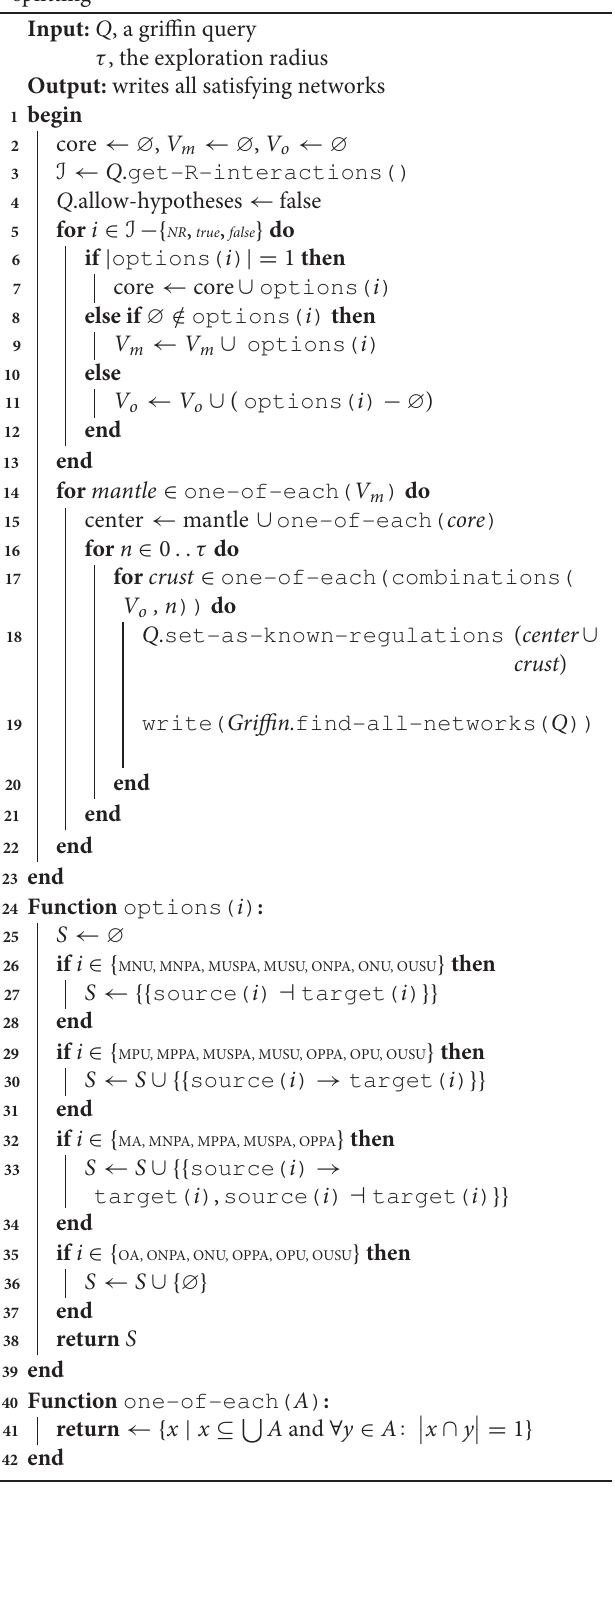
Algorithm 2: Radial exploration strategy for query